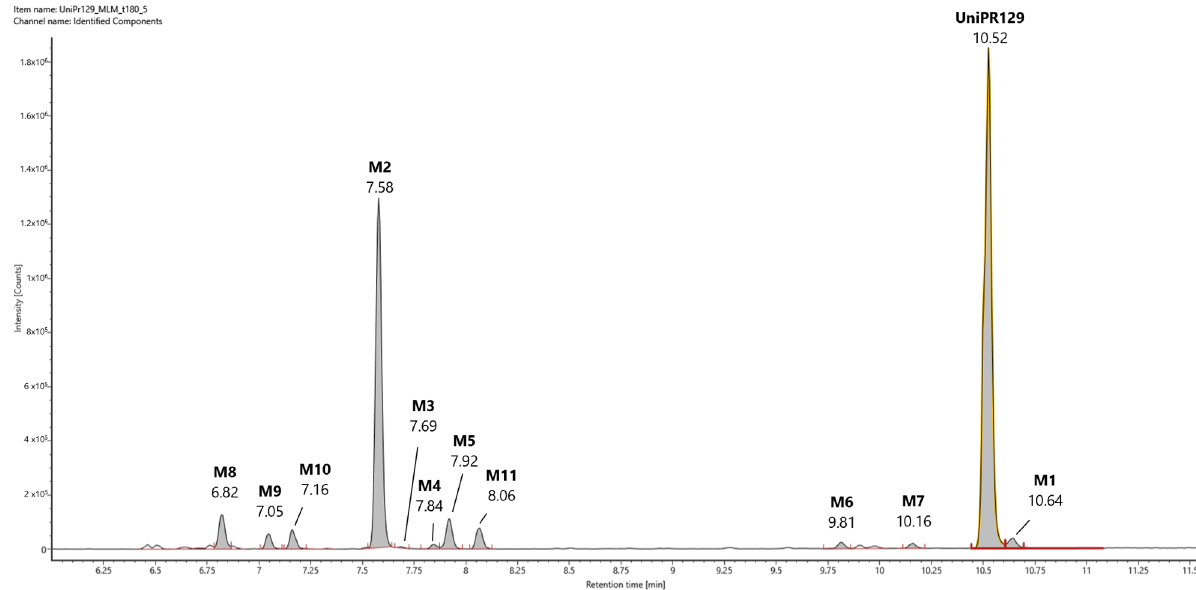
Figure 3. Representative UHPLC-HR-MS chromatogram in positive electrospray ionization (ESI + ) of a MLM incubation of UniPR129 (100 μ M) ( t = 180 min).